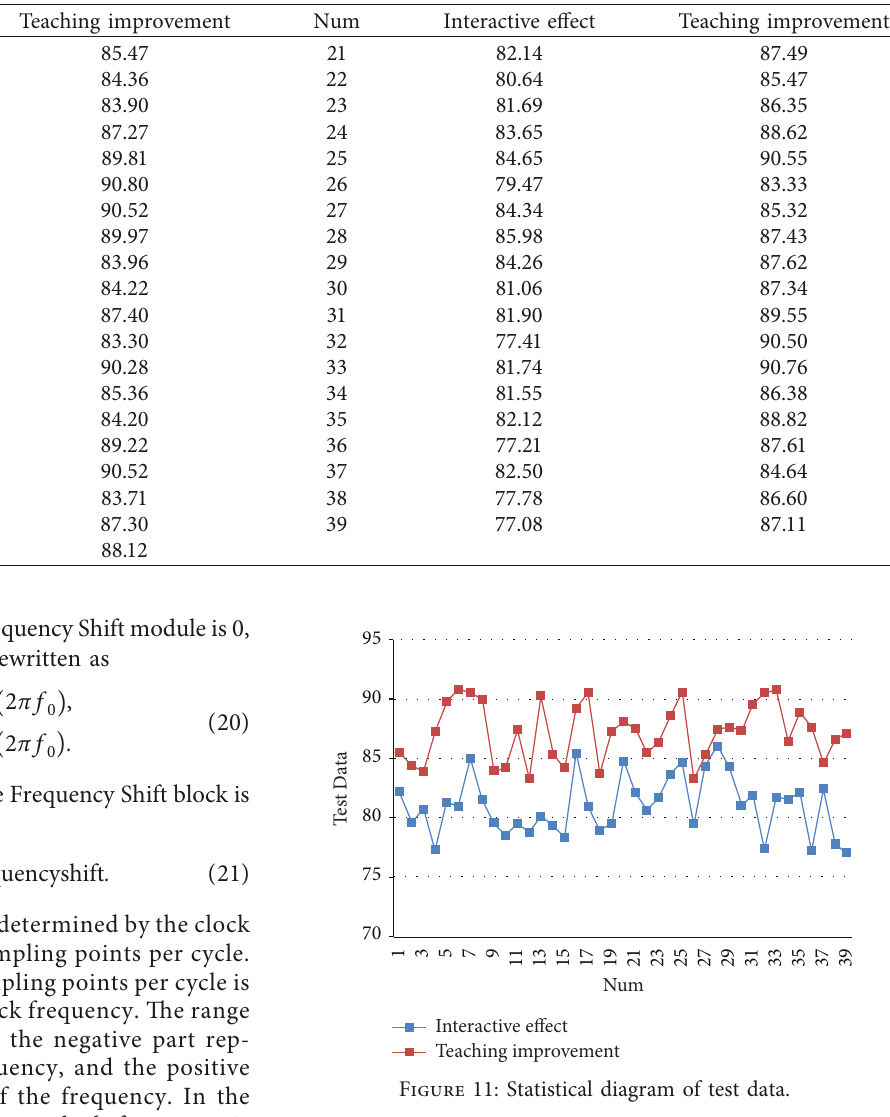
Table 1: Experimental data.